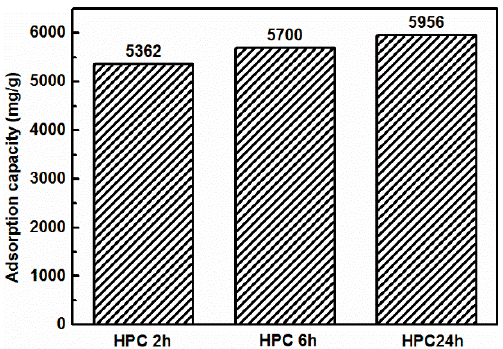
Figure 11. The adsorption capacity of 0.05 g HPC aged for different times (2 h, 6 h, and 24 h).